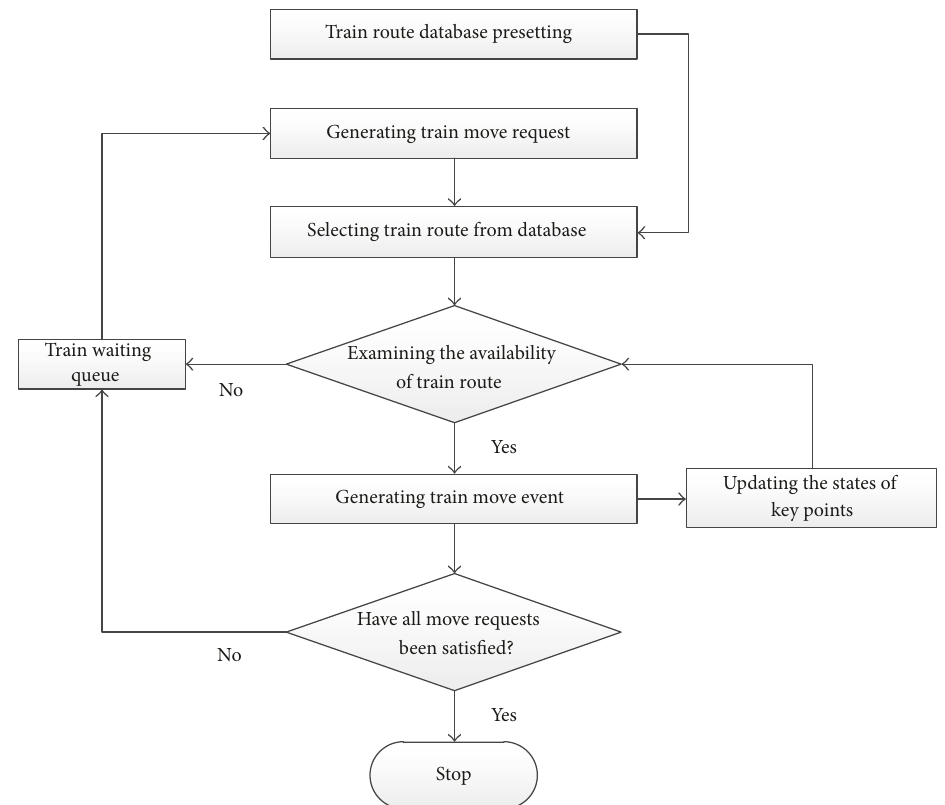
Figure 6: Framework of train route dispatching simulation